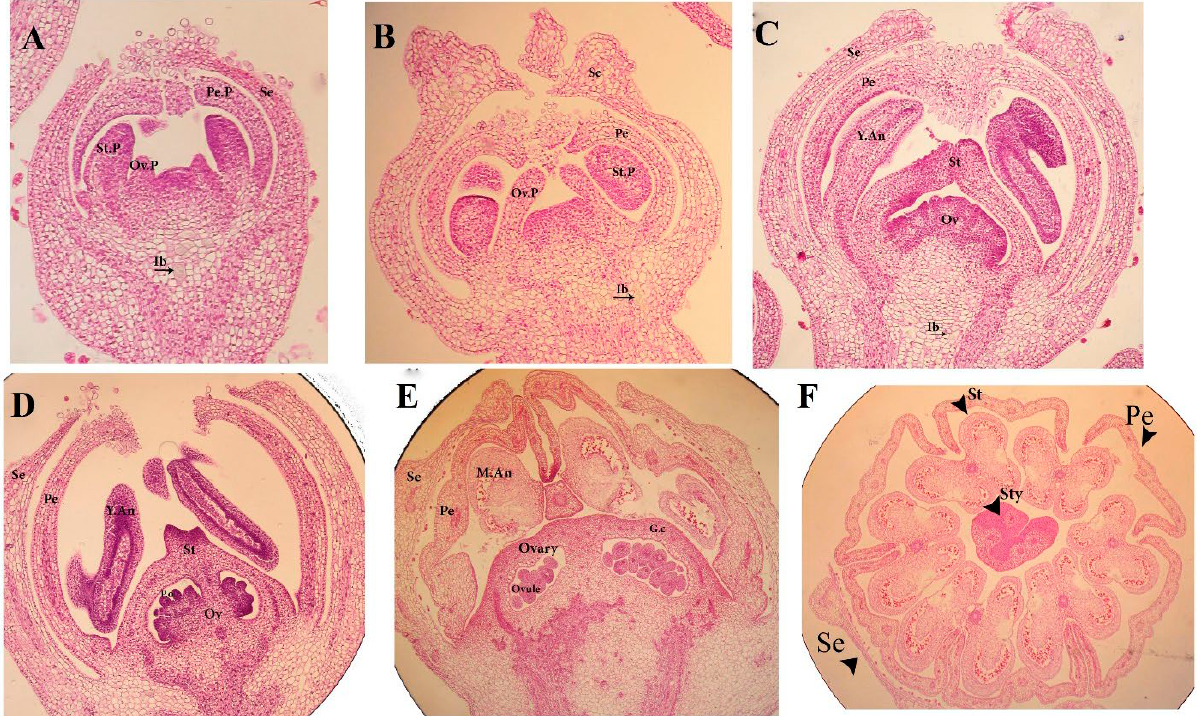
Figure 2. Longitudinal section of floral bud in different stages of flower development: (A): Stage 1. (B): Stage 2. (C): Stage 3. (D): Stage 4. (E): Stage 5; (F) Transverse section of floral bud (Ib – Idioblast; M.An – mature anther; Ov.p – ovary primordium; P – Petal; Pe.P – Petal Primordium; P.o – ovule primordium; Se – Sepal; St.p – stamen Primordium; St - stigma; St: stamen; sty – style; Y.An – young